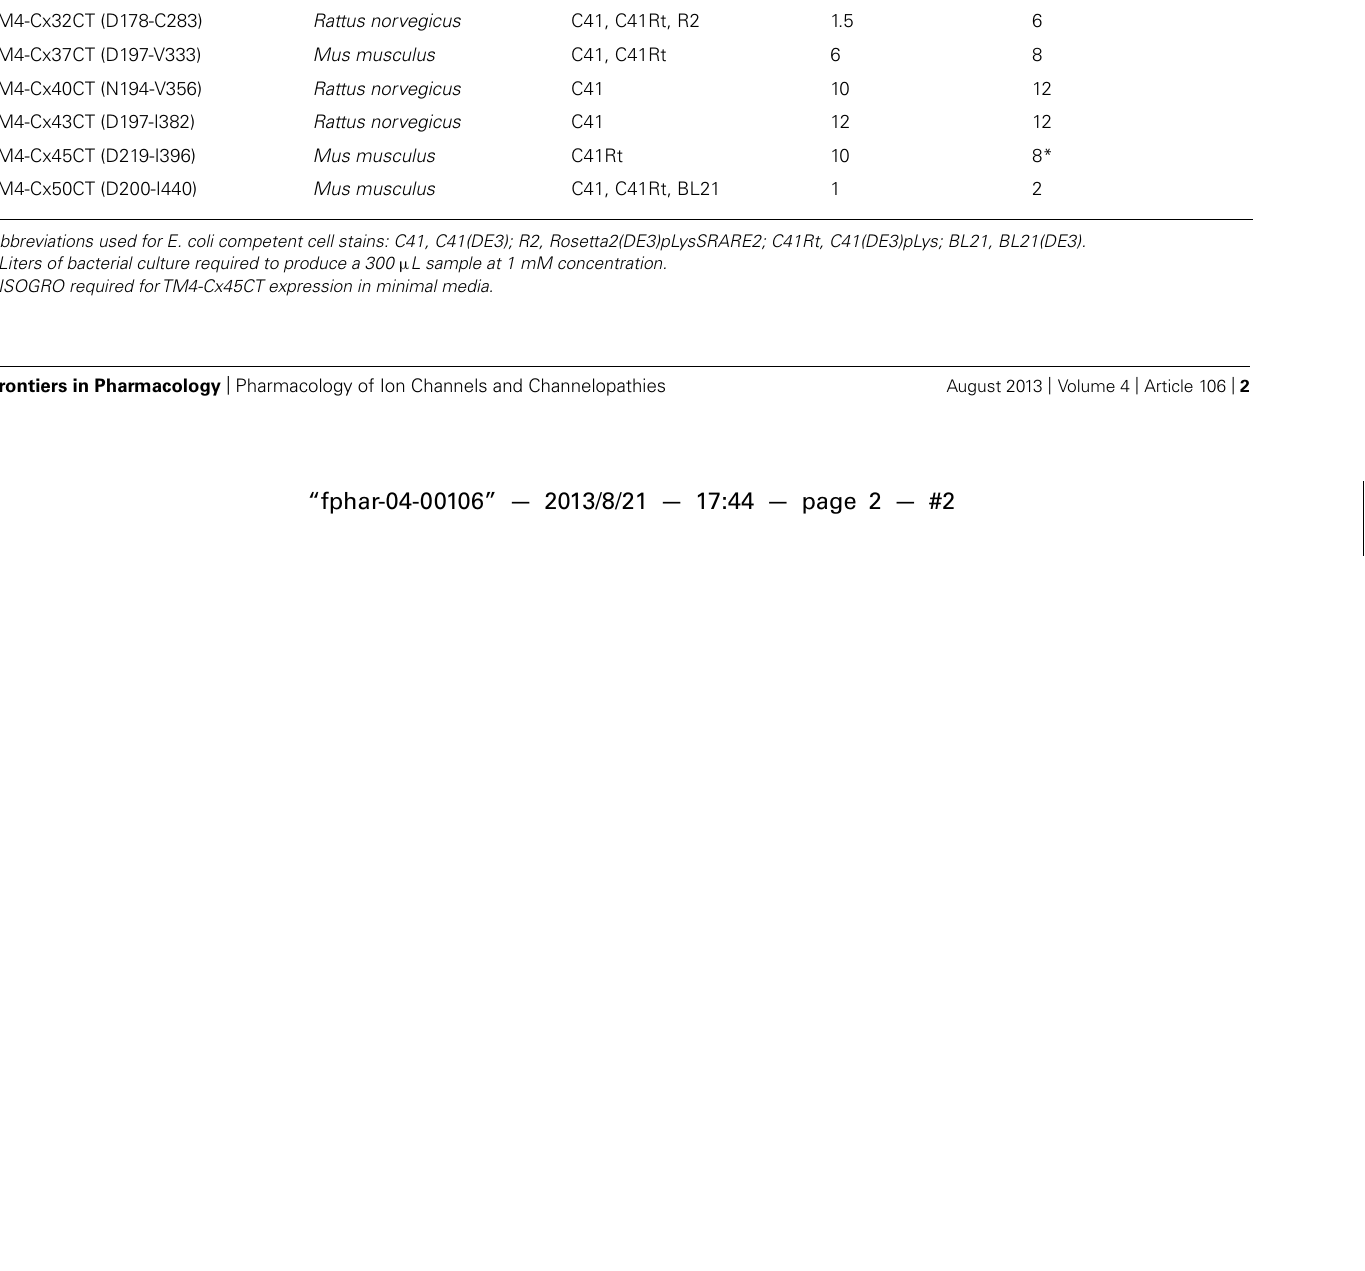
Table 1 | Conditions used to produce NMR samples for eachTM4-CxCT construct. Connexin isoform Species Optimal cell line